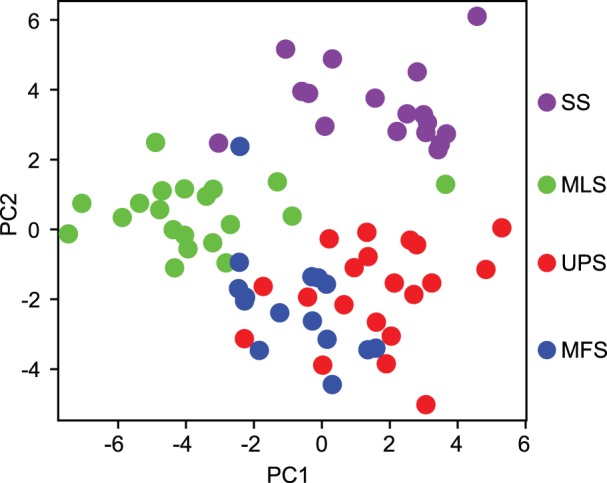
Principal component analysis using 29 probe sets for 4 histological types.The x-axis and y-axis represent the first and second principal components (PC1 and PC2), respectively. Each dot represents a sample colored according to its histological type. UPS: undifferentiated pleomorphic sarcoma, MLS: myxoid liposarcoma, SS: synovial sarcoma, MFS: myxofibrosarcoma.